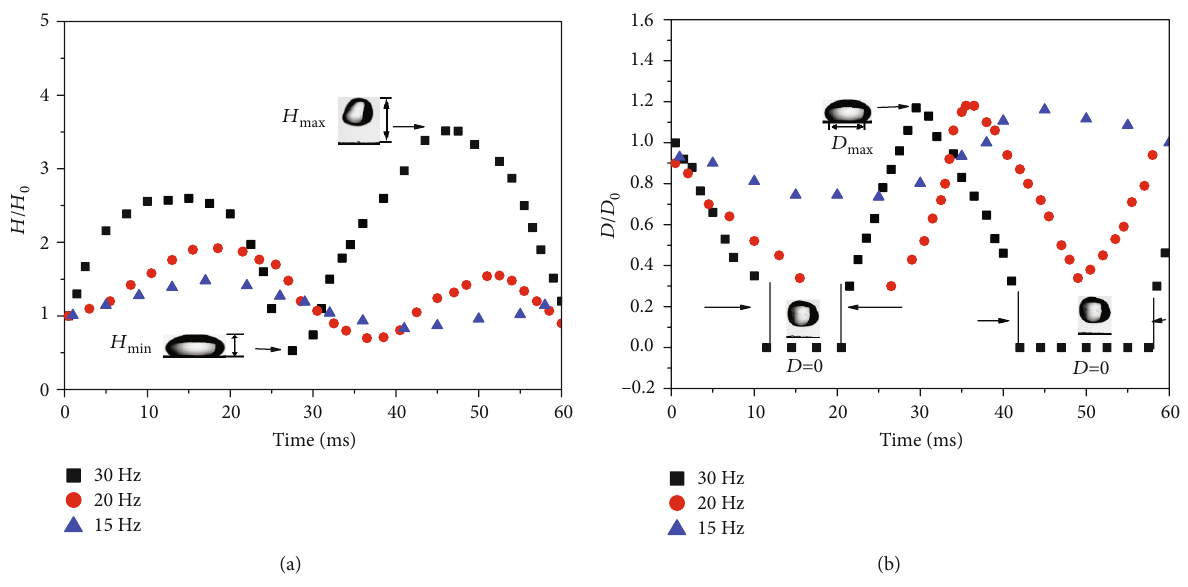
Figure 7: The change rate of the droplet with time under di ff erent frequencies: (a) height of droplet and (b) wetting diameter of droplet.